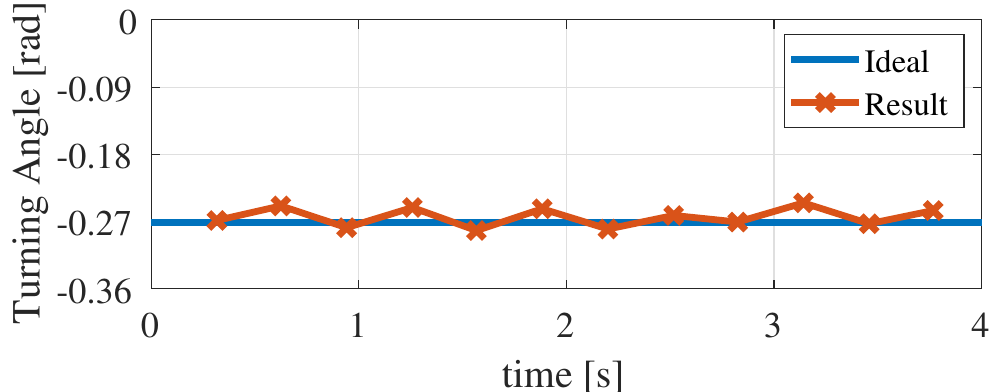
Figure 24. The time variation of the turning angle in the ninth clockwise turning locomotion experiment.